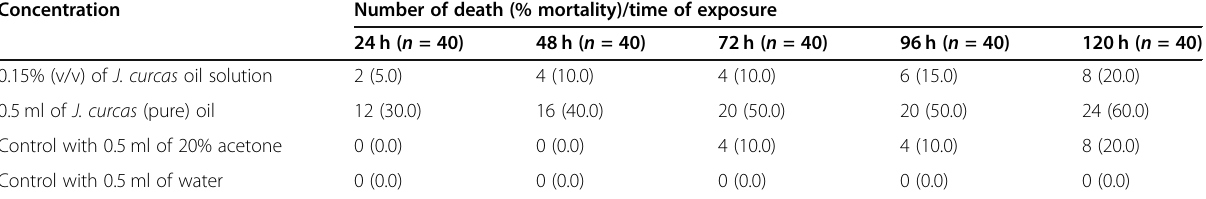
Table 3 Fumigant toxicity effect of J. curcas oil solution and pure oil on P. americana Concentration Number of death (% mortality)/time of